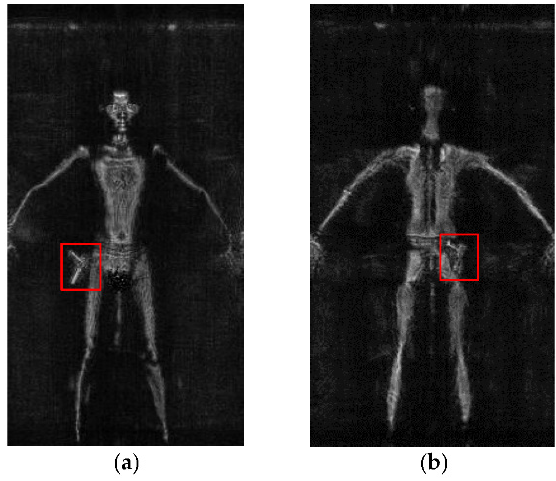
Figure 2. Body image. ( a ) Target position 1, ( b ) Target position 2.